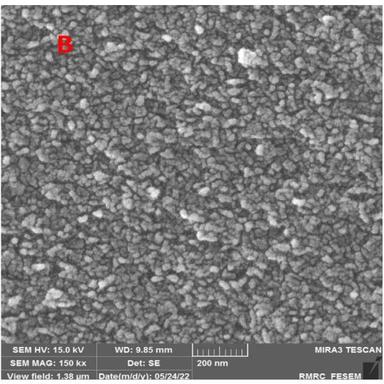
FESEM image of synthesized (A) γAl2O3, (B) Ti-γAl2O3, and TEM image of (C) γAl2O3, and (D) Ti-γAl2O3 and particle size distribution histograms (inset in C and D).